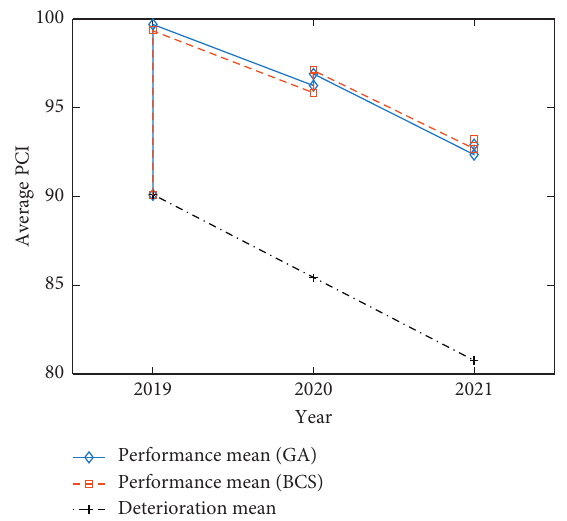
Figure 12: Pavement performance under biobjective model.